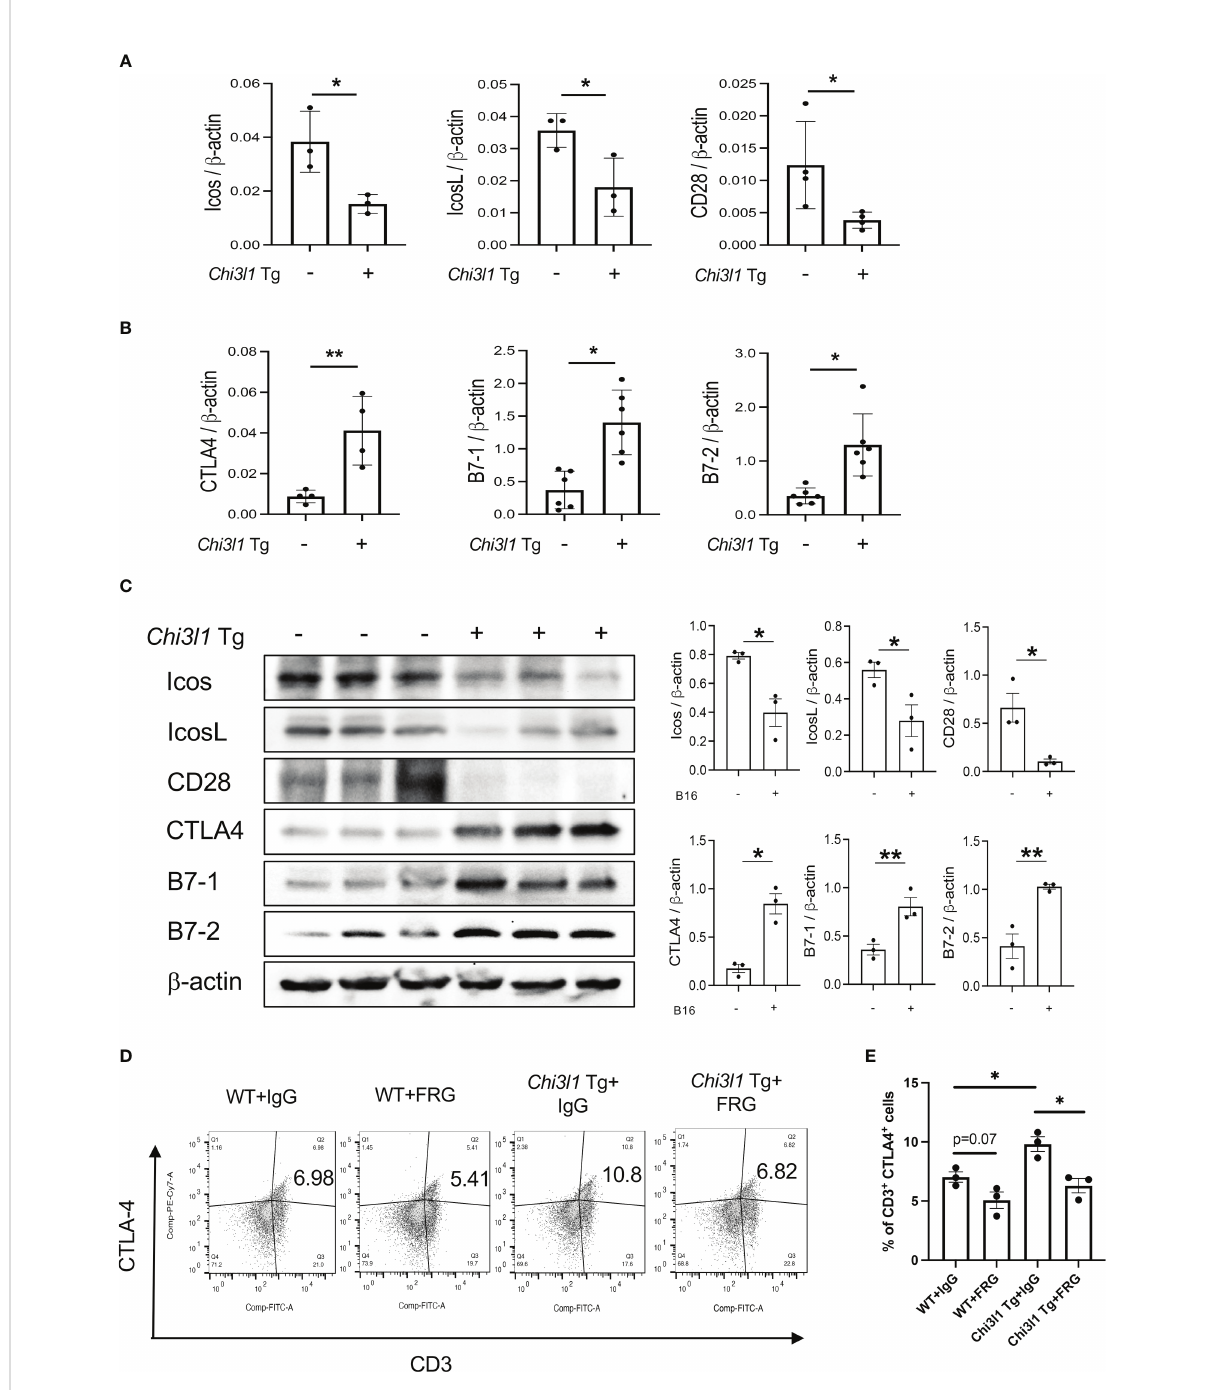
FIGURE 4 Chi3l1 inhibits co-stimulation and stimulates pulmonary CTLA-4 in the normal lung. WT and Chi3l1 Tg (+) mice were used to evaluate the effects of transgenic Chi3l1 on co-stimulation and the CTLA-4 axis. (A) RT-PCR was used to quantitate the levels of mRNA encoding ICOS, ICOS L and CD28 in the lungs from WT mice and Chi3l1 Tg+ mice. (B) RT-PCR was used to quantitate the levels of mRNA encoding CTLA-4, B7-1and B7-2 in the lungs from WT mice and Chi3l1 Tg+ mice. (C) Western blot and densitometry evaluations of ICOS, ICOSL, CD28 B7-1 and B7-2 accumulation in lungs from WT and Chi3l1 Tg+ mice. (D) FACS evaluations quantitating the accumulation of CTLA-4 in CD3+ cells from WT mice and Chi3l1 Tg+ mice. (E) Cumulative FACS evaluations quantitating the accumulation of CTLA-4 in CD3+ cells from WT and Chi3l1 Tg+ mice. The plotted values in panels (A, B, E) represent the mean ± SEM of the noted evaluations represented by the individual dots. Panel C is representative of a minimum of 2 similar evaluations. * P < 0.05, ** P < 0.01 ( t -Test for panels (A, B) , ANOVA with multiple comparisons for panels E